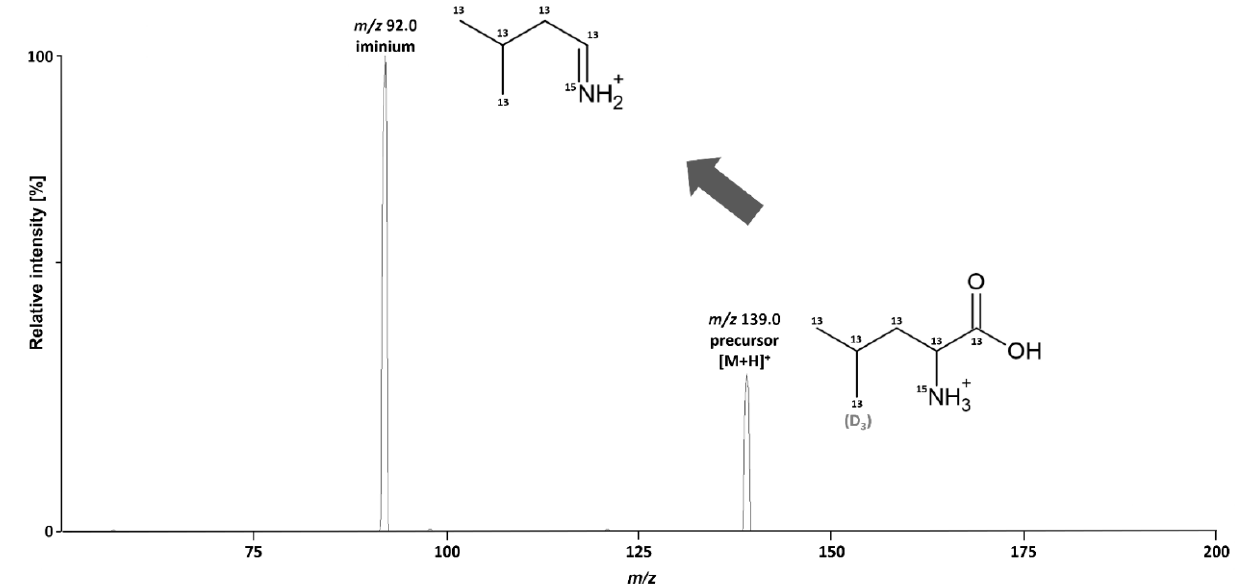
15 N]-L-leucine at a collision energy of 9 6 ,